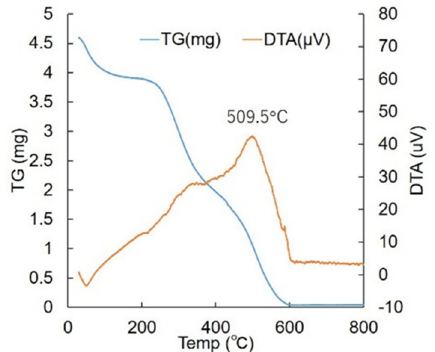
Figure 6. Thermogravimetric analysis and differential thermal analysis (TG/DTA) of the gelatin sponge. The blue line indicates the TGA results and the orange line indicates the DTA results.